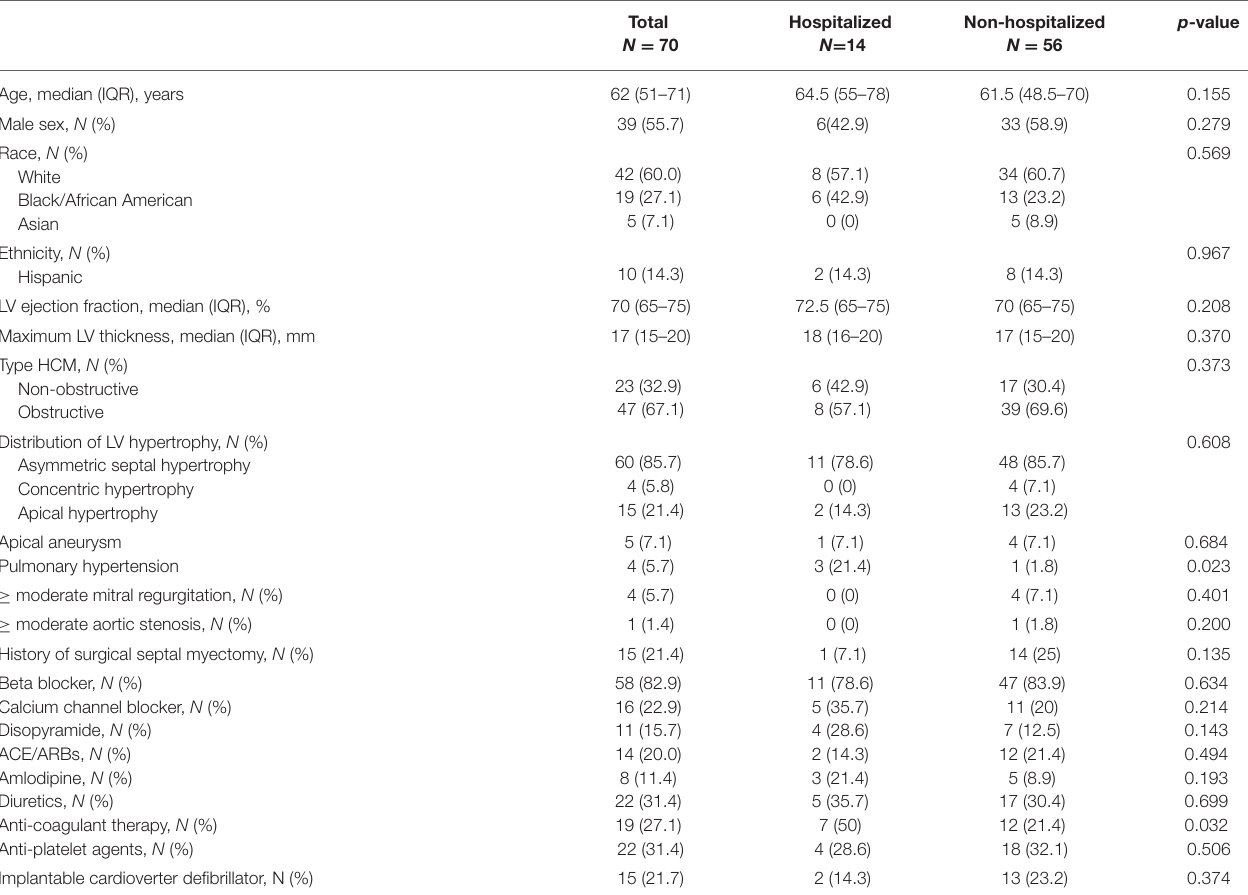
TABLE 1 | Demographics and baseline HCM